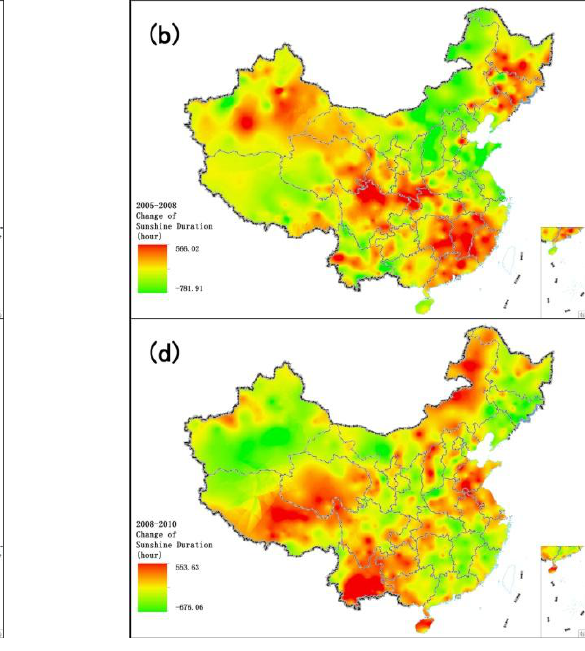
Figure 20. Change in meteorological conditions over China during 2005–2010. ( a ) Change in rainfall from 2005 to 2008; ( b ) Change in sunshine duration from 2005 to 2008; ( c ) Change in rainfall from 2008 to 2010; ( d ) Change of sunshine duration from 2008 to